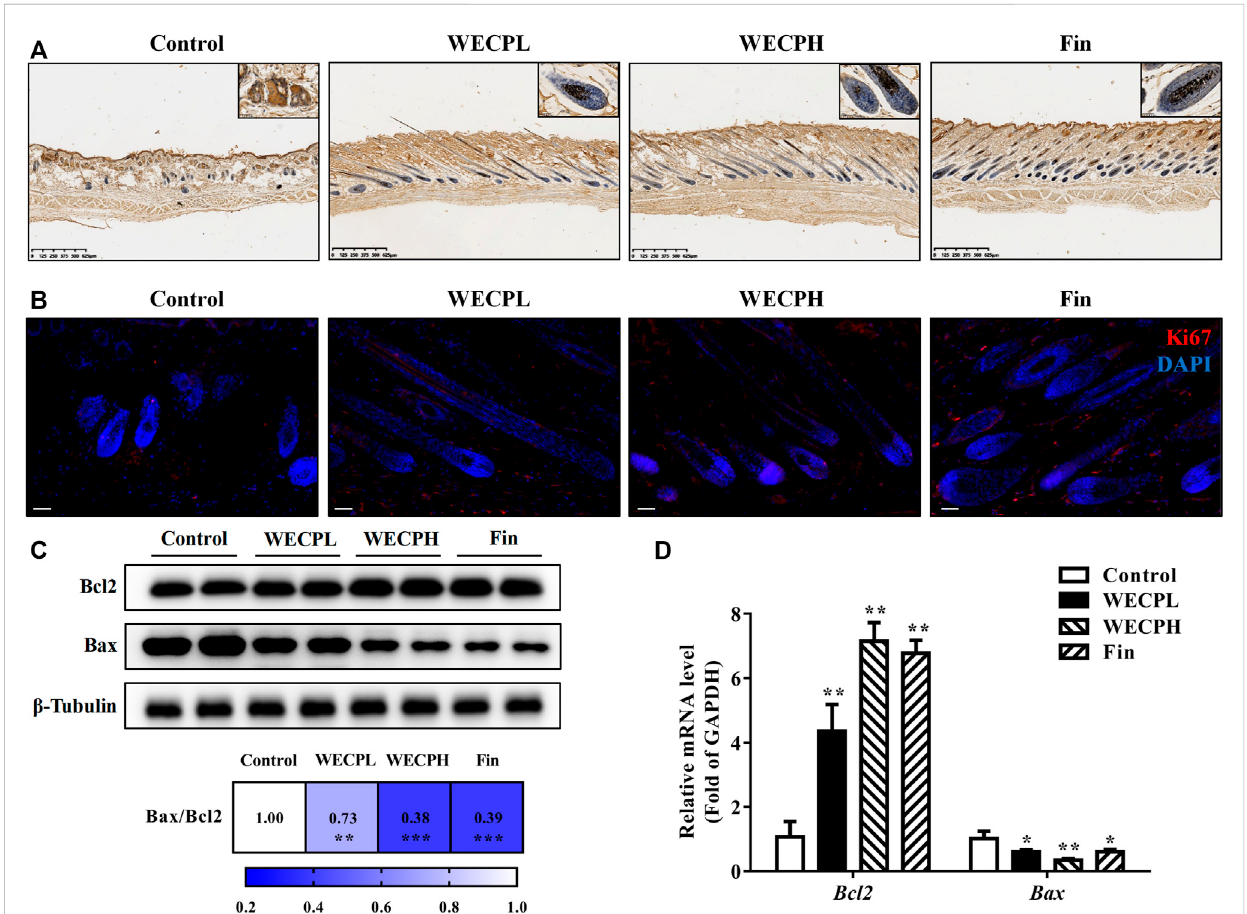
WECP attenuates apoptosis and promoted HF cells proliferationin in denuded mouse skin. (A) Representative sections showing TUNEL staining of hair follicles in mouse skin. Scale bars = 625 μ m. (B) Representative sections showing Ki67 staining of hair follicles in mouse skin. Scale bars = 50 μ m. Effects of WECP and fi nasteride treatments on (C) translational and (D) transcriptional expression of Bcl2 and Bax in mouse skin. Data are presented as means ± SD of three independent replicates. * p < 0.05, ** p < 0.01, *** p < 0.001 vs. control